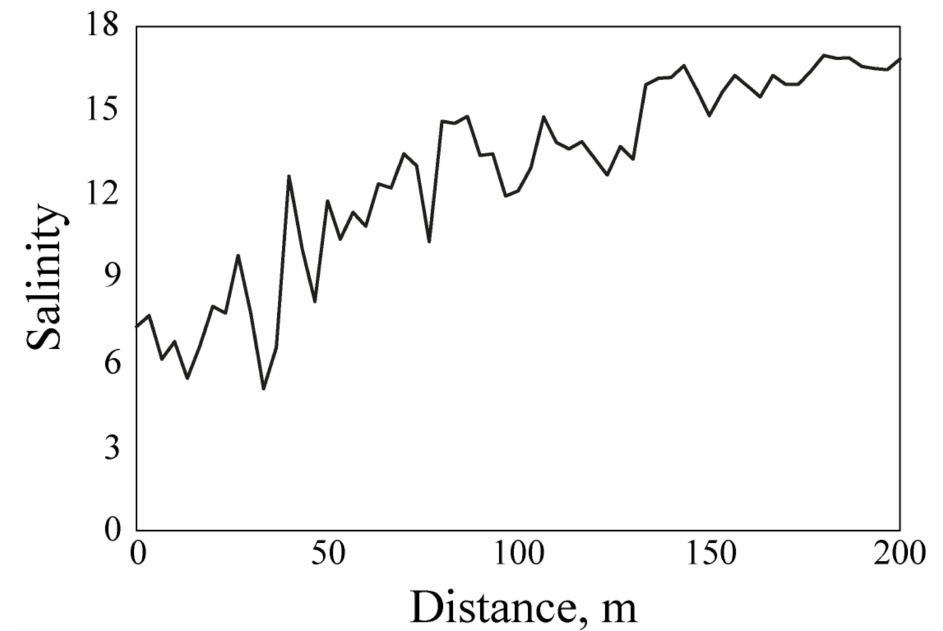
Figure 9. Salinity at a depth of 1.5 m measured from the free-drifting buoy on 18 April at 10:44–10:49 in the central part of the jet. The trajectory of the buoy is indicated by the left green line in Figure